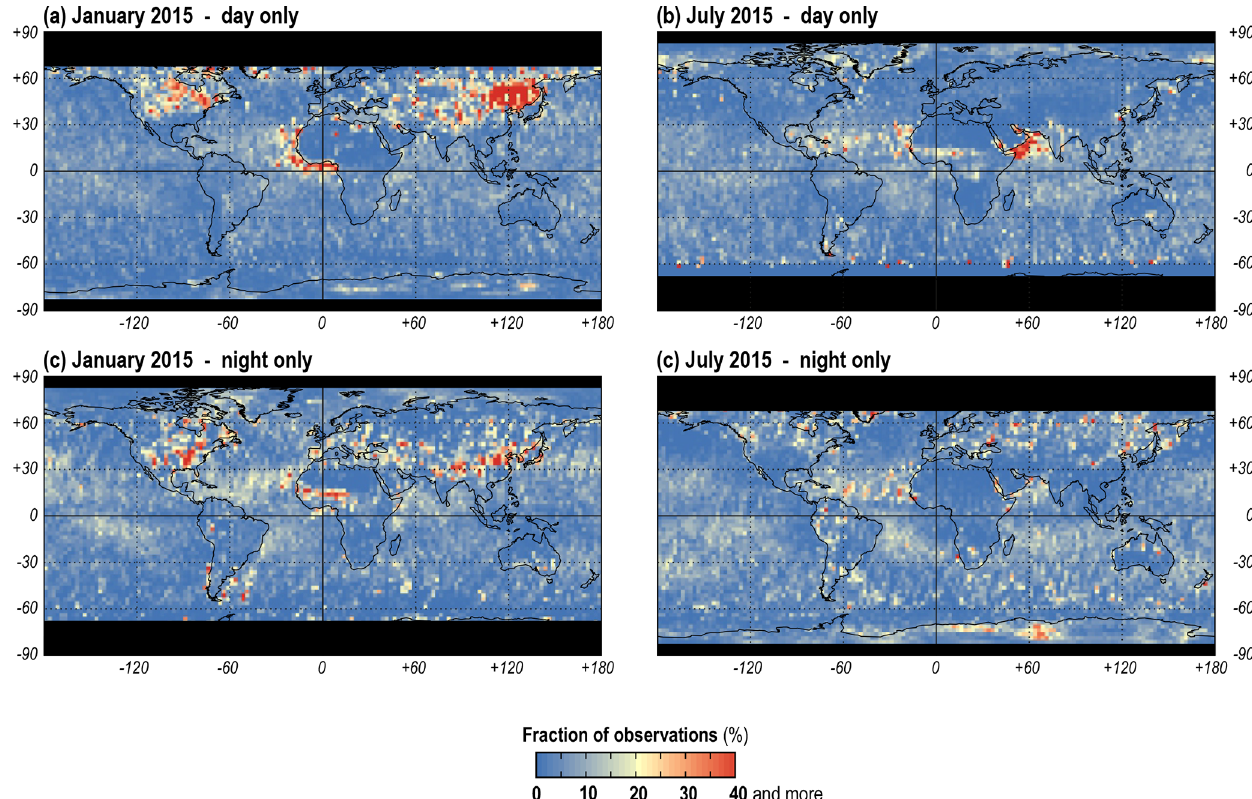
Figure 2. Observations declared confident cloudy or probably cloudy by the MODIS cloud masking algorithm but identified as clear by CALIOP. Table 2. Global cloud fractions for MODIS cloud mask classes derived from CALIOP observations (‘This study”) and used in the